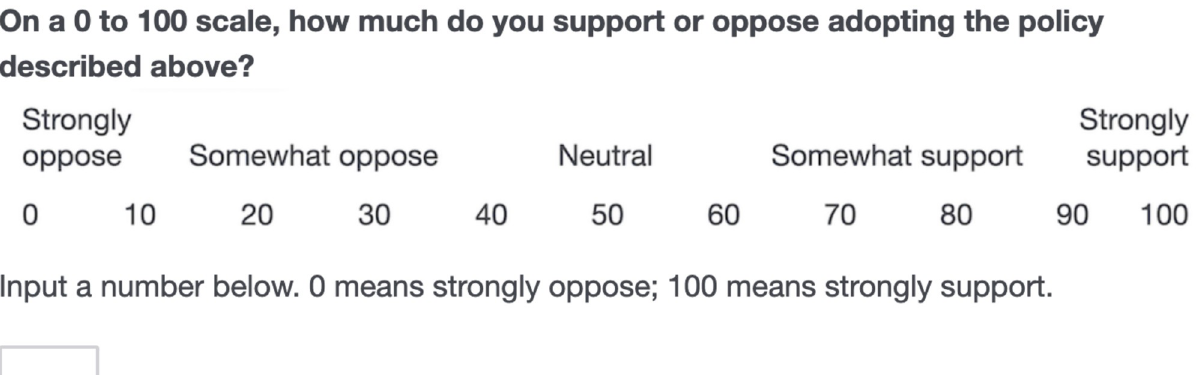
Fig 2. Survey response input for assessing policy